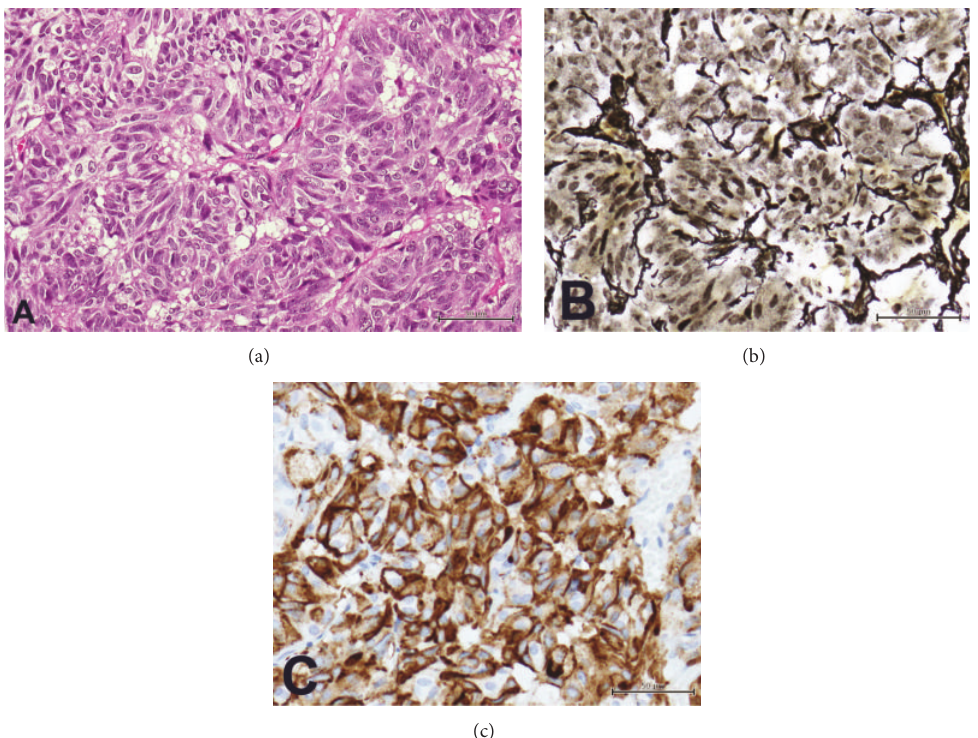
Figure 2: Pathology of TSH pituitary adenoma. Numerous adenoma cells with oval-shaped nuclei are intervened by delicate capillaries (a). Disruption of reticulum framework is depicted (b). Tumor cells are immunoreactive with TSH (c). (A, hematoxylin and eosin; B, reticulin stain; and C, TSH immunostain; each bar = 50